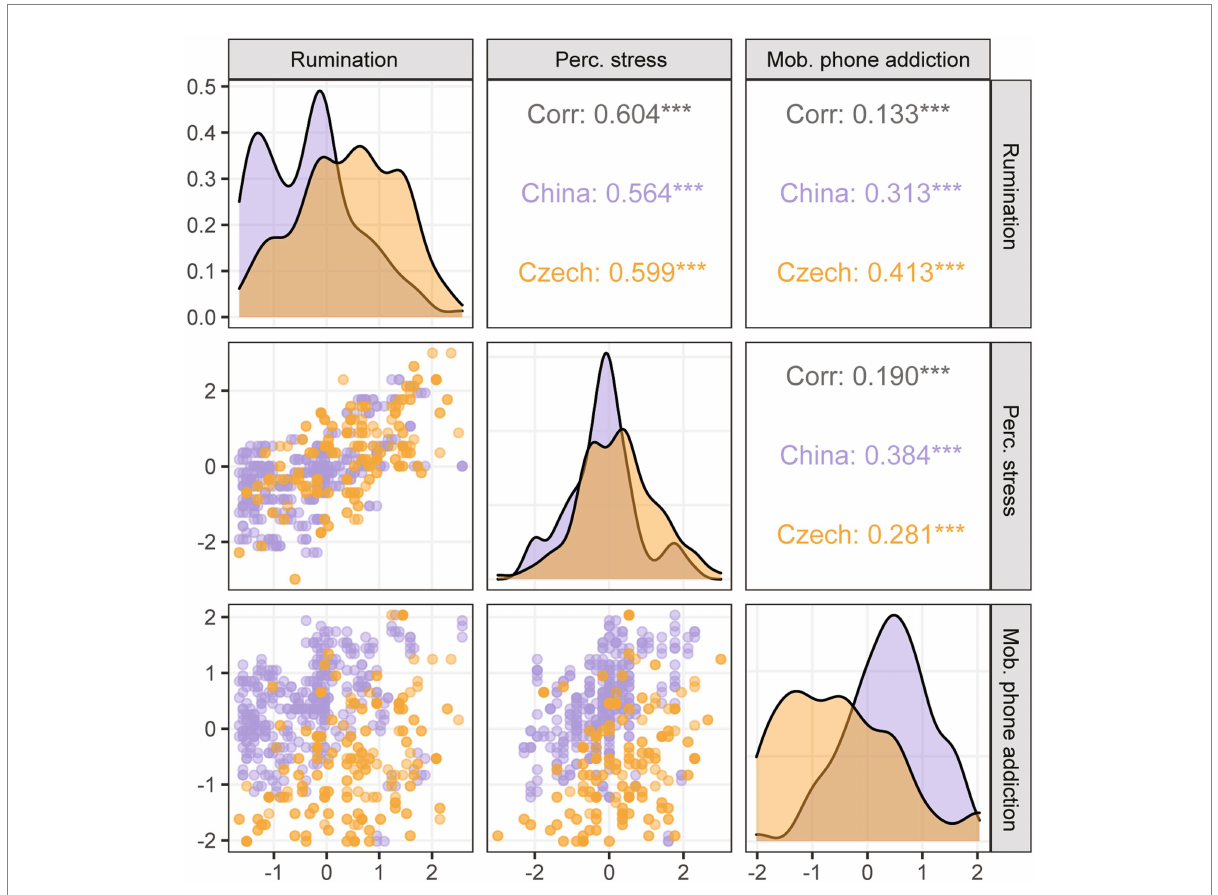
FIGURE 1 Correlations between main outcomes. Correlation matrix showing the density plot of the z-scores of each variable, the scatterplot of the distribution of values in both countries and the strength of the correlations between the variables. *** p < 0.001.